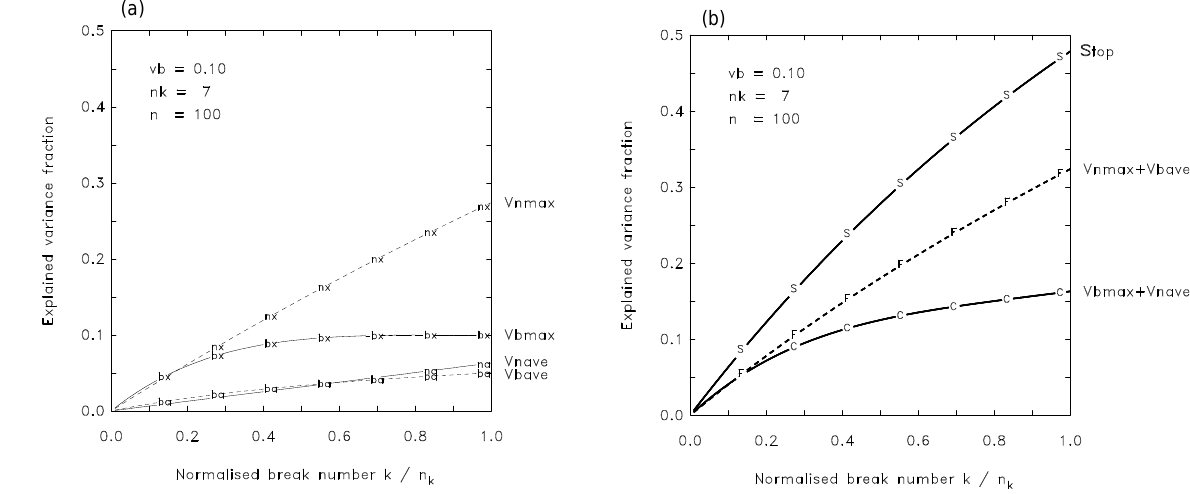
Figure 8. (a) Explained variances as given by Eqs. (5) to (8) for a time series of length 100 containing seven breaks with a SNR of 1 / 3. (b) Explained variances as given by Eqs. (5) to (8). As (a) , but for the summed up correct ( C = V bmax + V nave ) and false ( F = V nmax + V bave ) combinations, and the stop criterion ( S ), which has to be